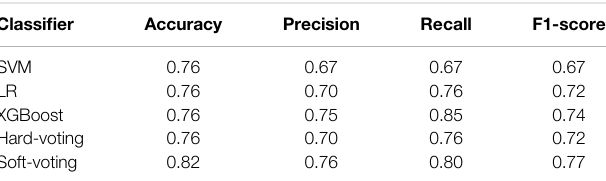
TABLE 4 | Further performance of the combination of XGBoost, SVM, and LR on the test set. Classi fi